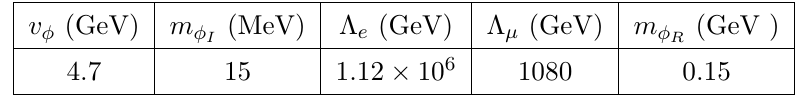
Table 2 . The benchmark for EFT model. The parameter y (cid:22) is determined by muon mass which is not listed here. The EFT model has 2 d.o.f., m (cid:30) and m (cid:30) , after applying all the constraints and I R signal requirements. The change of m (cid:30) only a(cid:11)ects (cid:3) (cid:22) , while v (cid:30) and (cid:3) e are already (cid:12)xed by the R electron mass and (cid:1) a e . m (cid:30) is limited to a small range 10 100 MeV by relevant constraints. This I (cid:0) benchmark is labeled as a black star in (cid:12)gure 1.